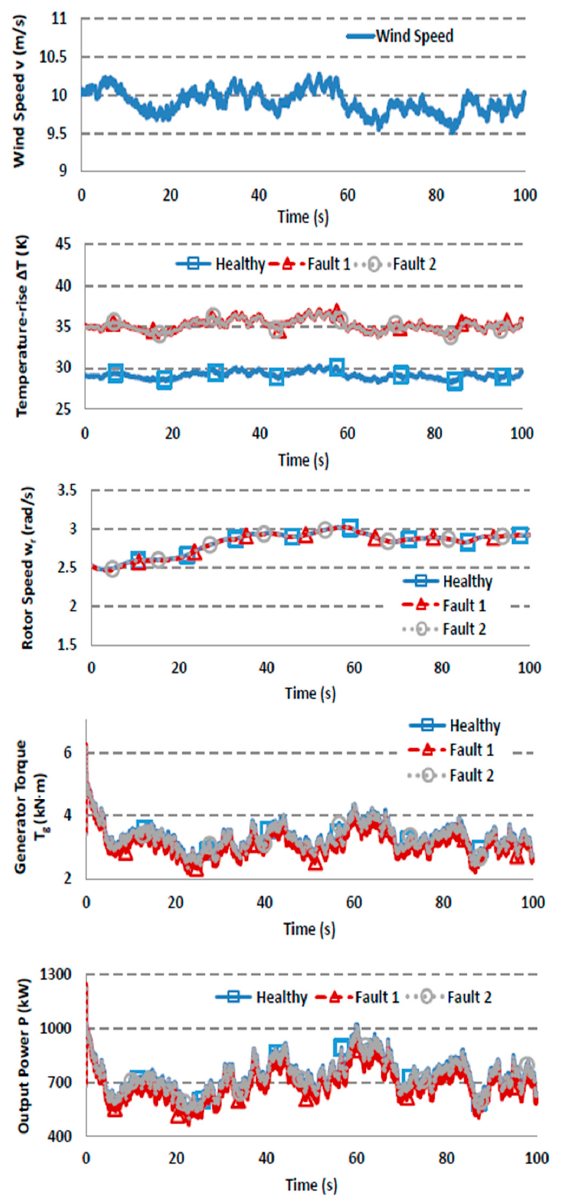
Figure 3. Simulation results of a WT in three states: healthy, with Faults 1 and 2.